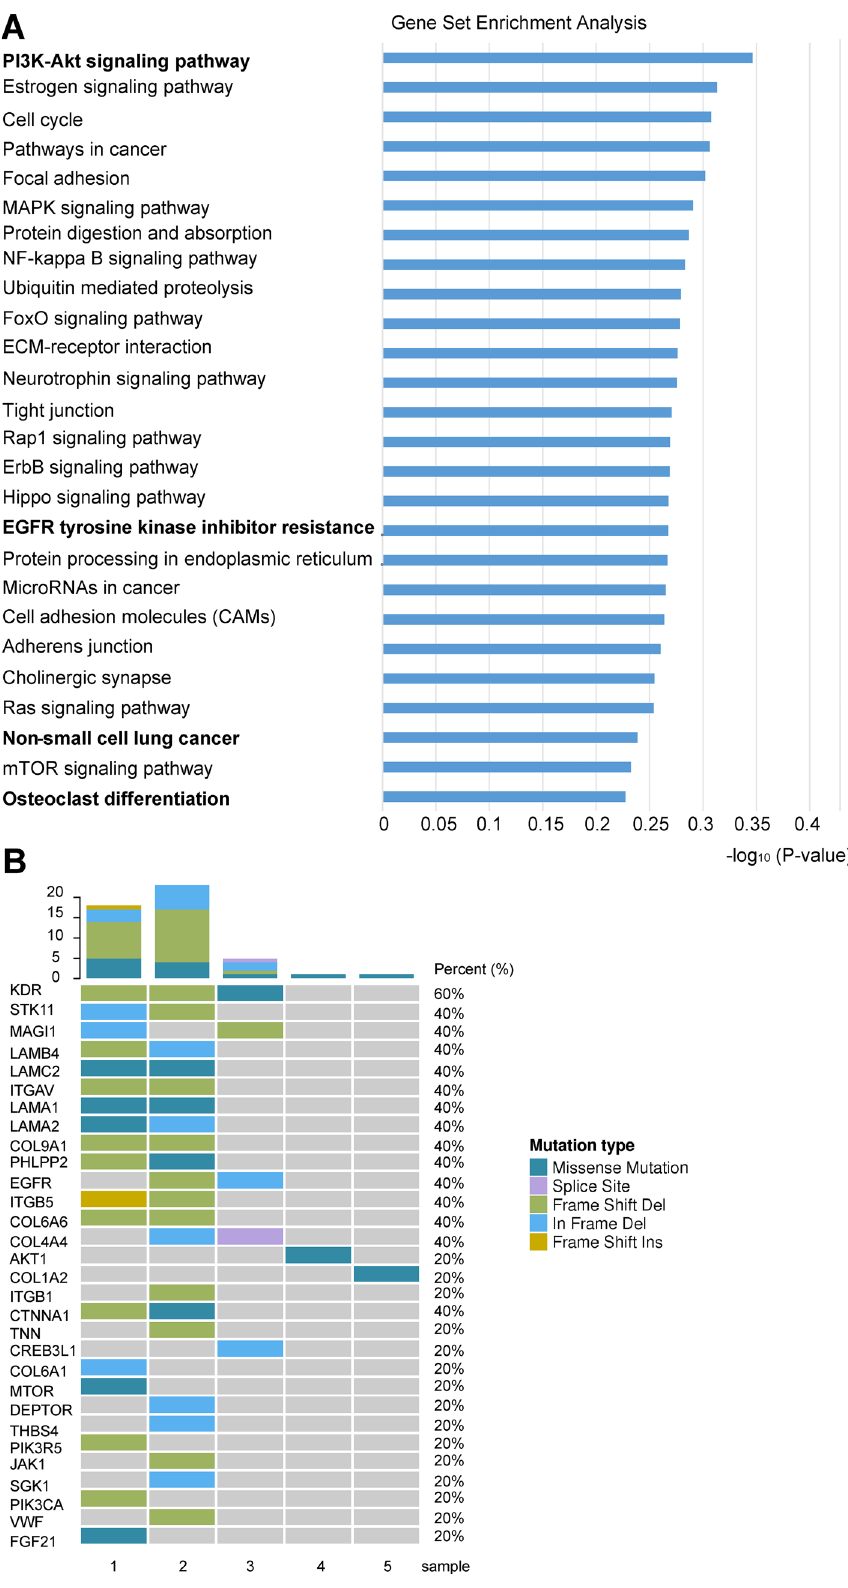
Figure 3. Analysis of significantly mutated genes (SMGs) revealing PI3K/AKT signaling pathway deregulation in 5 ALK-positive lung cancer samples compared to paired adjacent normal tissues through whole-exome sequencing. ( A ) Pathway enrichment of SMGs. The bar graph shows that KEGG passway terms are enriched in SMGs, the X axis indicates P values in the specified formula. All KEGG terms are statically significant (adjusted P value < 0.05). ( B ) Landscape of significantly mutated genes related to PI3K/AKT signaling